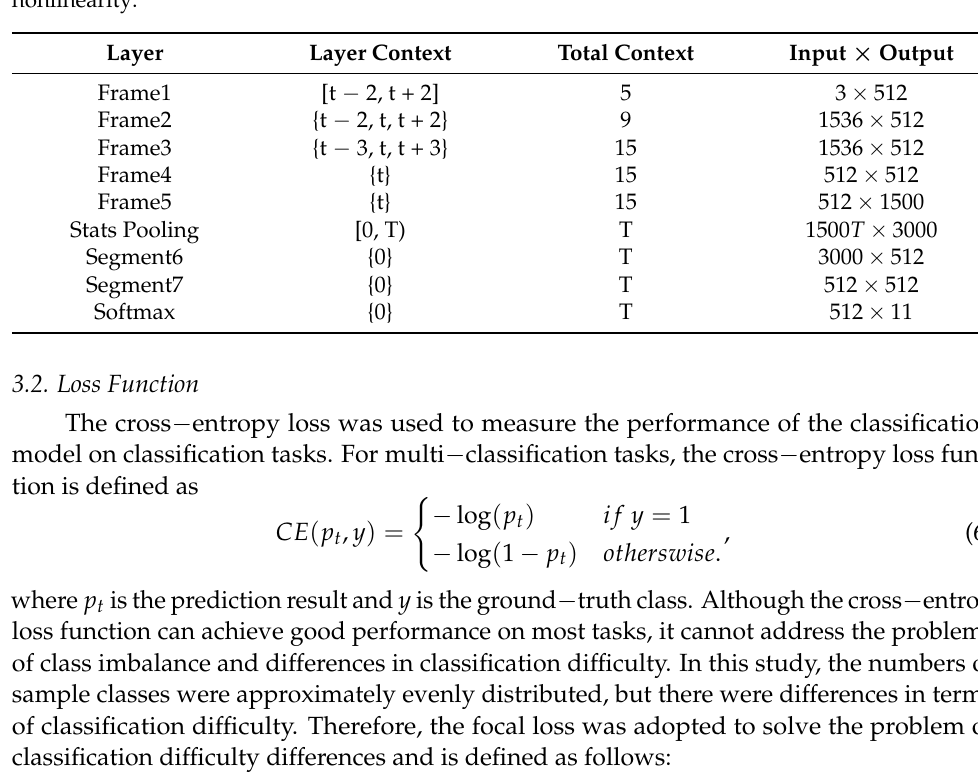
Table 3. The architecture of the DNN. The x − vectors are extracted at layer segment6, before the